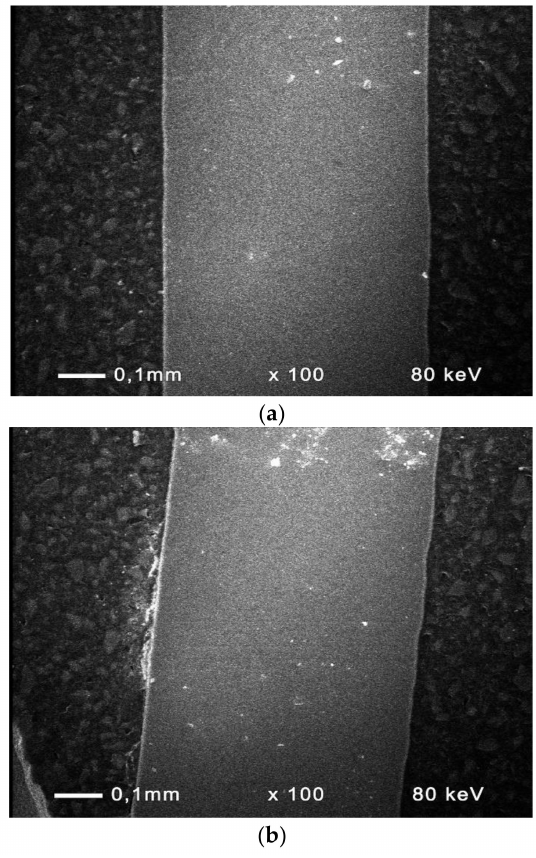
Figure 9. Cross-sections of samples T25 ( a ) and T100 ( b